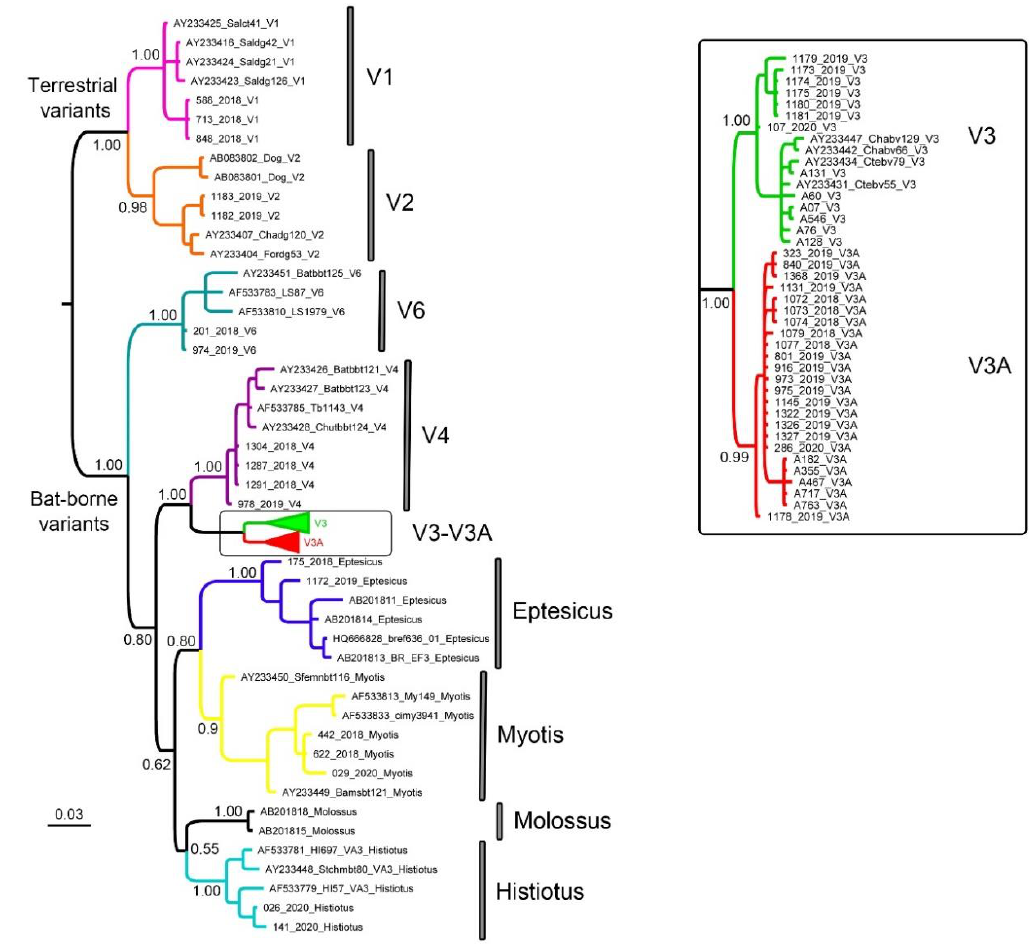
Figure 2. Bayesian phylogeny of 87 sequences based on 191 bp involving the 3′ terminus of the RABV N gene and 51 downstream nucleotides. Bayesian posterior probability of main clades is shown, as well as the scale (substitutions/site). In the left panel, the subclade (V3, V3A) is expanded.